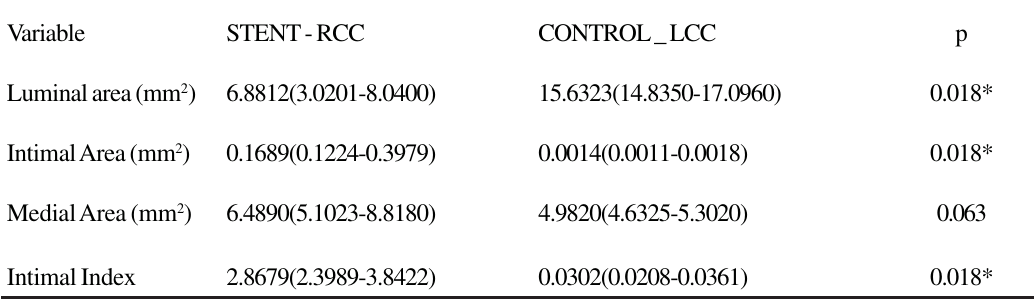
TABLE 2 - Morphometric analysis of areas in the STENT group